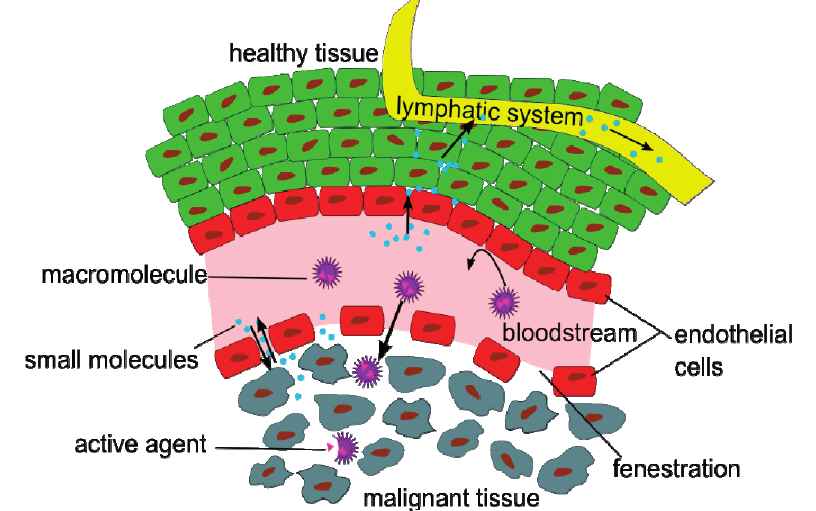
Figure 8. Illustration of the Enhanced Permeation and Retention (EPR) effect of macromolecular structures as drug delivery systems in malignant tissue. Data from